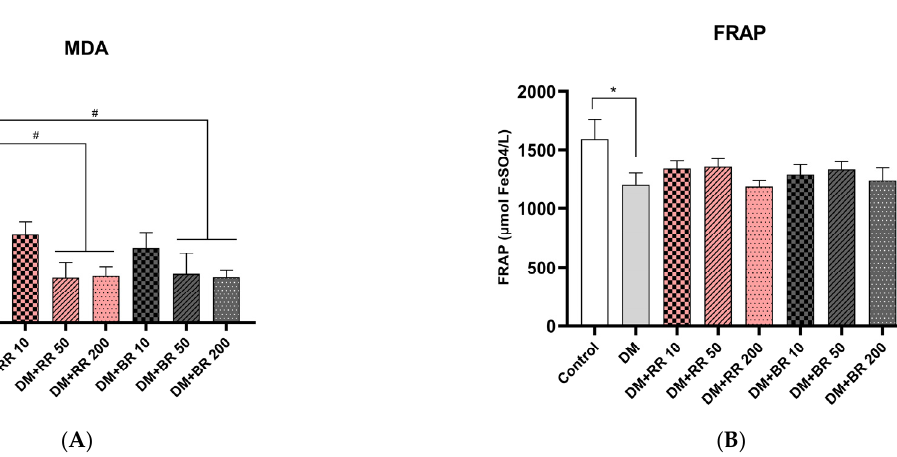
Figure 3. Effects of RR and BR on MDA ( A ) and FRAP ( B ) . Values represent mean ± S . E . M . (n = 8) . * P < 0 . 05, diabetic control group vs . control group; # P < 0 . 05, treated group vs . diabetic control.